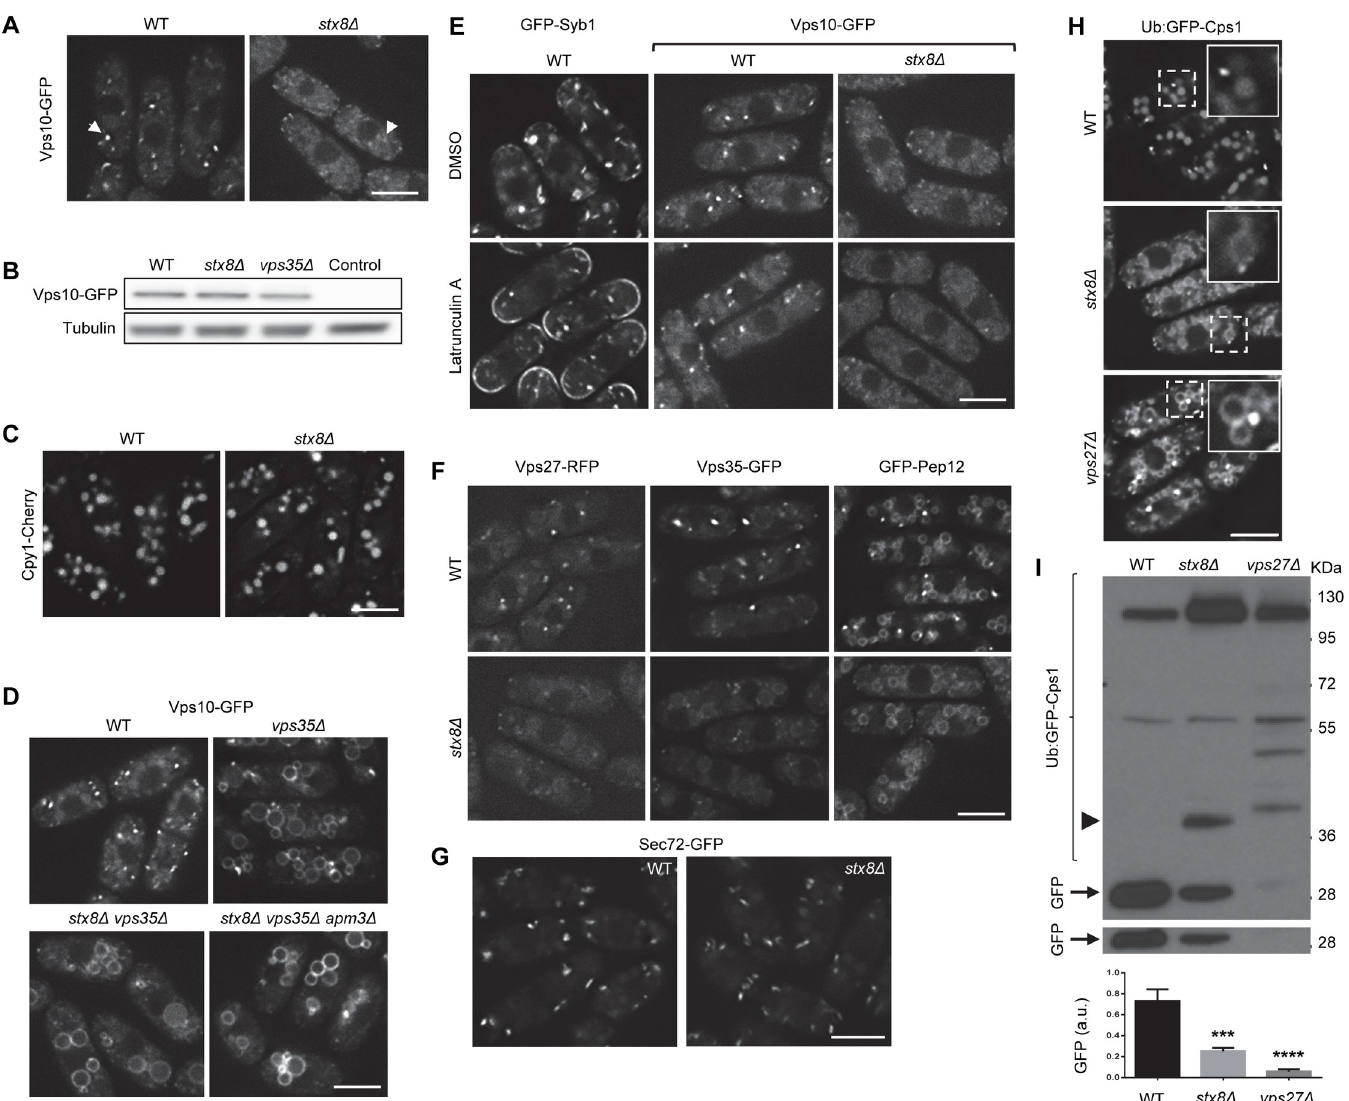
Fig 1. Stx8 is required for the morphology and functionality of the prevacuolar endosome (PVE). (A) Localization of Vps10-GFP in wild type (WT) and stx8 Δ cells. Arrowheads denote cytoplasmic fluorescent dots. (B) The level of Vps10-GFP in cell extracts from the WT, stx8 Δ and vps35 Δ strains was analyzed by western blot. Cell extracts from a strain that did not express Vps10-GFP was used as a negative control. Tubulin was used as loading control. (C) Cpy1-Cherry distribution in the same strains as in (A). (D) Vps10-GFP distribution in the indicated strains. (E) WT cells bearing either GFP-Syb1 or Vps10-GFP, and stx8 Δ cells bearing Vps10-GFP were treated with dimethyl sulfoxide (DMSO; solvent) and with latrunculin A for 20 minutes and photographed. (F) Distribution of the indicated PVE markers in WT and stx8 Δ cells. (G) Distribution of the trans -Golgi network (TGN) marker Sec72-GFP in WT and stx8 Δ cells. (H) Distribution of Ub:GFP-Cps1 in the indicated strains. For each image, the inset in the upper-right corner corresponds to an enlargement of the region delimited by dashed lines. (I) Equal amounts of protein in cell extracts from the indicated strains bearing Ub:GFP-Cps1 were subjected to western blotting with anti-GFP. The arrowhead denotes a 40 kDa band present in stx8 Δ , and the arrow denotes the clipped GFP. The lower panel shows a low exposure of the gel region where the clipped GFP was detected. The experiment was performed three times. The lowest panel shows the mean, standard deviation, and statistical significance of the differences in the amount of GFP (a.u., arbitrary units), determined by Dunnett’s multiple comparisons tests after analysis of variance (ANOVA). ��� , p < 0.001; ���� , p < 0.0001. Images are single planes captured with a DeltaVision system. Scale bar, 5 μ